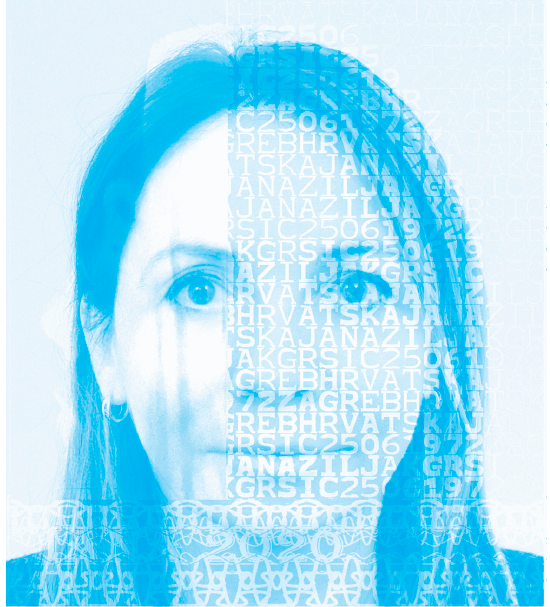
Figure 10. Cyan channel (C).